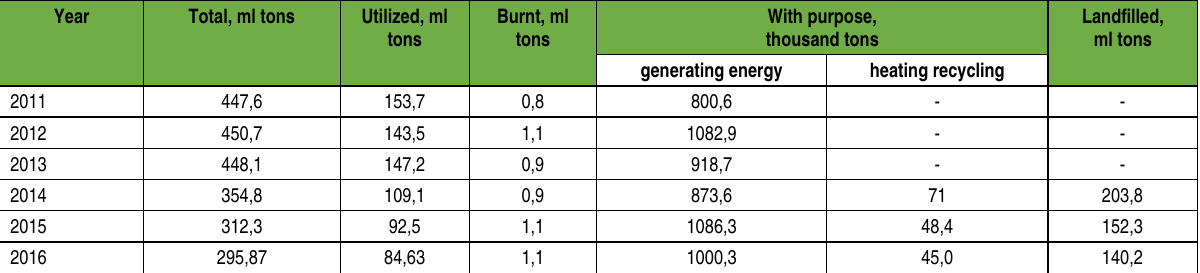
Table 4. The dynamics of waste in Ukraine